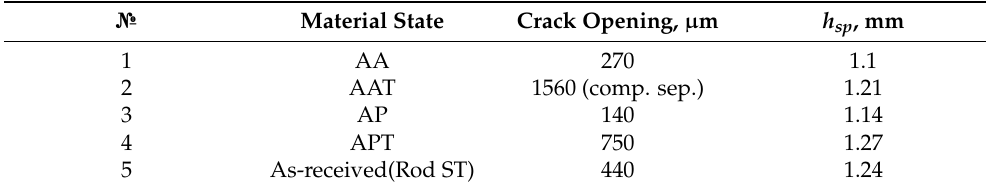
Table 6. The values of the maximum opening of the spall crack and the calculated thickness of the spall plate for the samples with a thickness of 4 mm. № Material State Crack Opening, µ